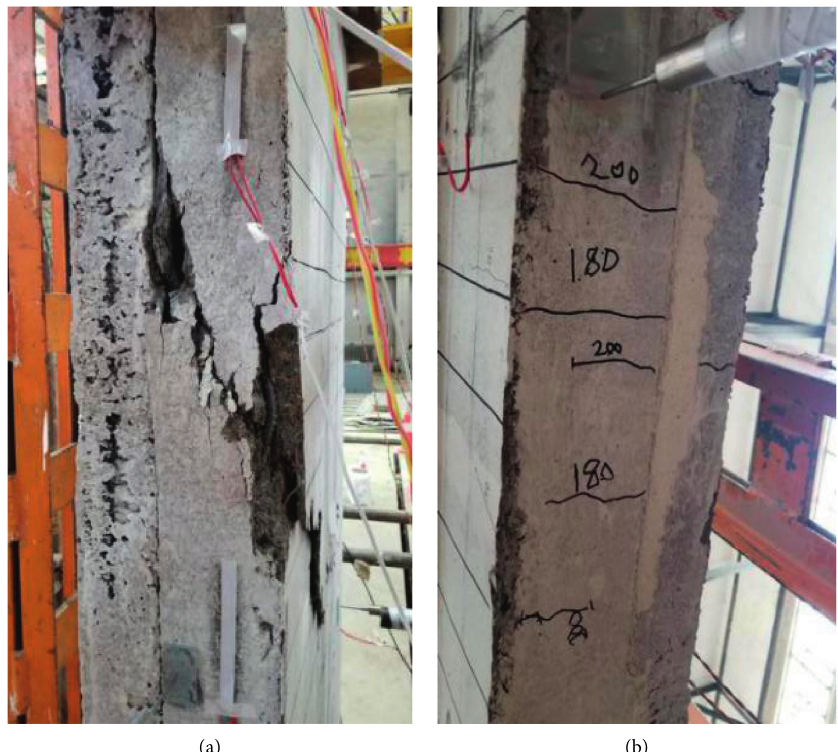
Figure 12: The experimental phenomena: (a) the damage of the middle column; (b) the cracks at the top of the